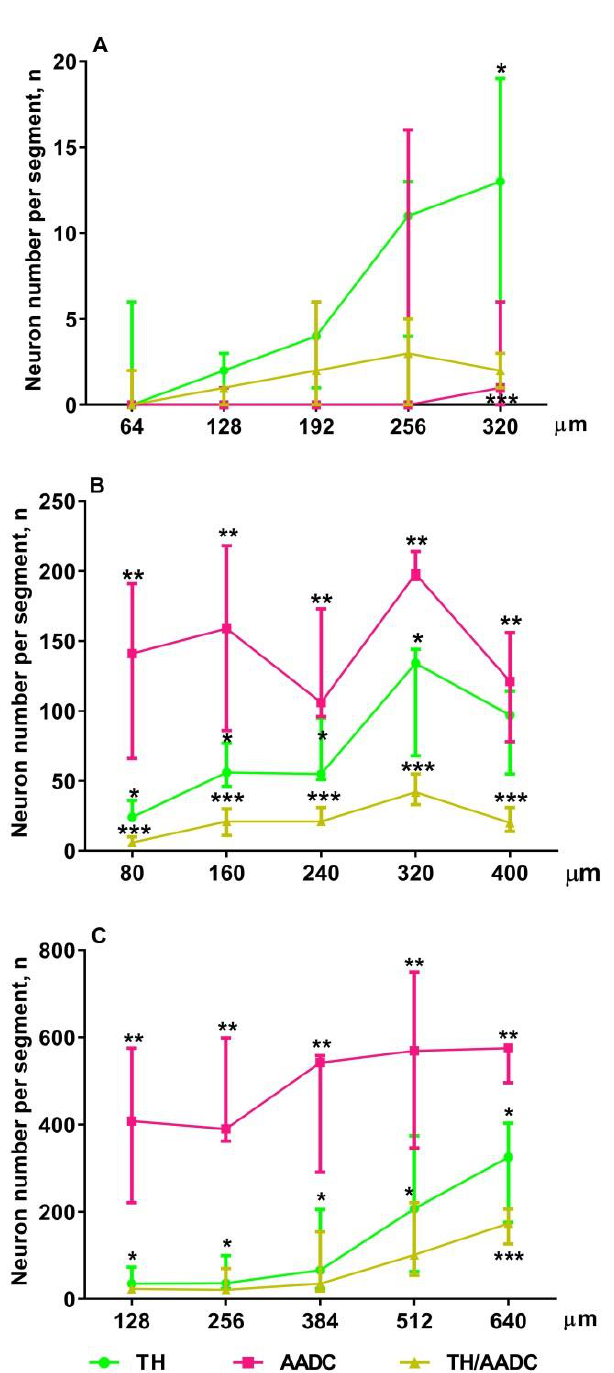
Figure 7. The number of neurons immunopositive only for tyrosine hydroxylase (TH), only for aromatic L-amino acid decarboxylase (AADC) and for both dopamine-synthesizing enzymes (TH/AADC) in five segments of the periventricular nucleus (PEN) of the same extent in the rostro- caudal direction in rats of each age: 64 µ m on embryonic day 18 (E18) ( A ), 80 µ m on E21 ( B ) and 128 µ m on postnatal day 5 (P5) ( C ). * p < 0.05, significant difference between the number of TH neurons and AADC neurons contained in the same PeVN segment; ** p < 0.05, significant differences between the number of AADC-neurons and TH/AADC-neurons contained in the same PeVN seg- ment; *** p < 0.05, significant difference between the number of TH/AADC-neurons and TH-neurons contained in the same PeVN segment (unpaired Wilcoxon test and Friedman test with Dunn’s post hoc test). Data are presented as median with interquartile